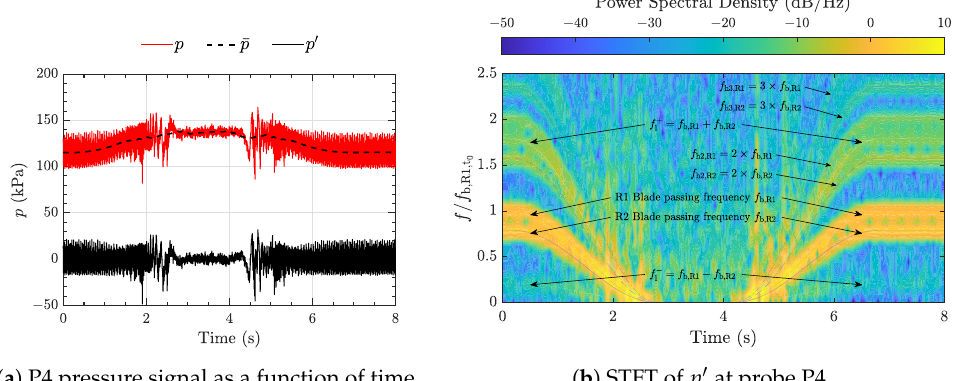
Figure 8. Signal of pressure probe P4 and spectrogram of the STFT of the fluctuating pressure component, during the transient sequence in turbine mode. Here, p is the pressure signal, ¯ p is the instantaneous average, and p (cid:48) is the fluctuating component. The frequency is normalised with, f b,R1,t , the blade passing frequency of Runner 1 at t 0 . Indices R1 and R2 denote Runners 1 and 0 2, respectively; b denotes the blade passing frequency; h2 is the second harmonic; h3 is the third harmonic; l is a linear